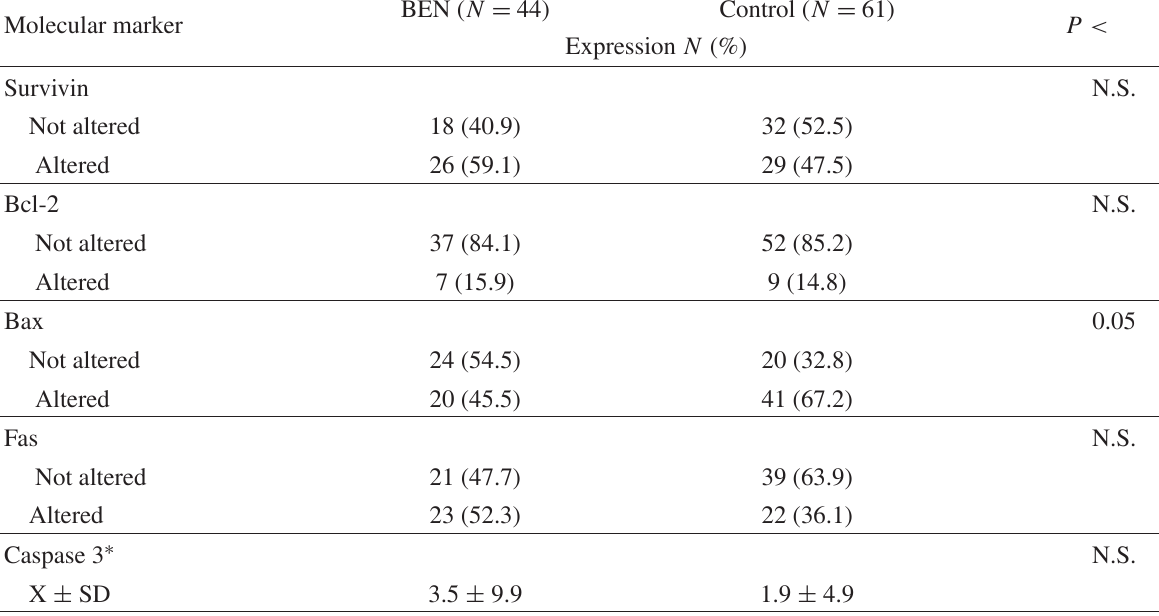
TABLE 3: Expression of apoptosis-related markers in UTUC associated with BEN and in control UTUC. Molecular